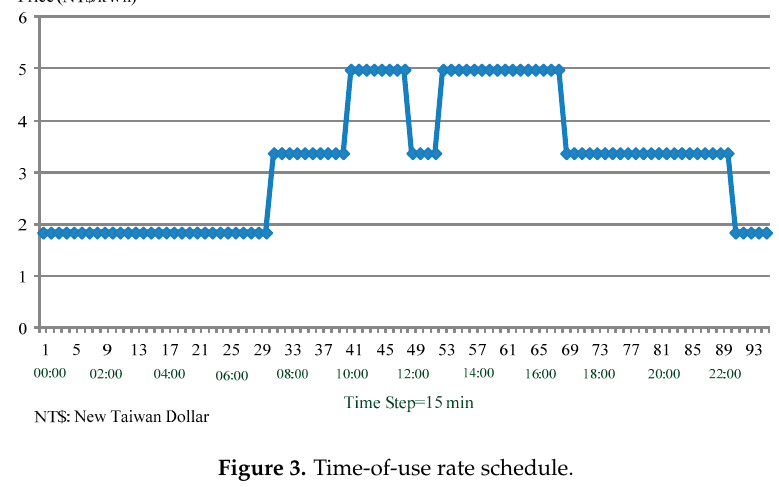
Figure 3. Time-of-use rate schedule.